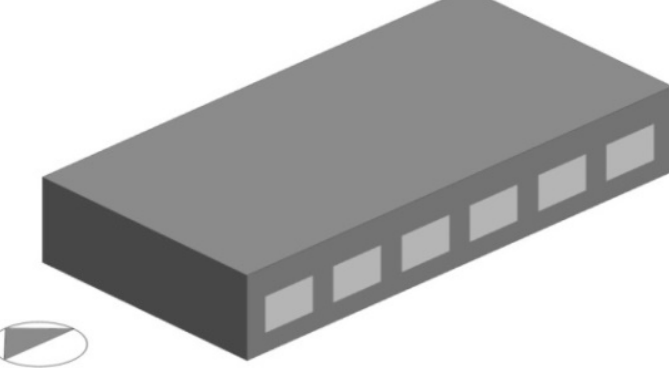
Figure 3. Simulated building in the DesignBuilder software with a 30% window in the south façade.